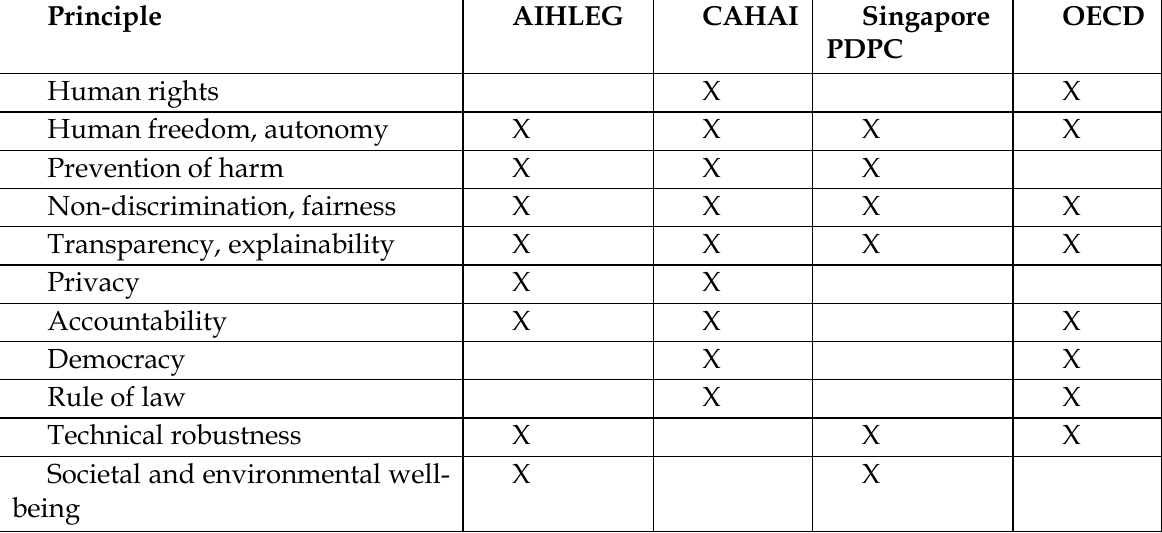
Table 1: Key principles in international